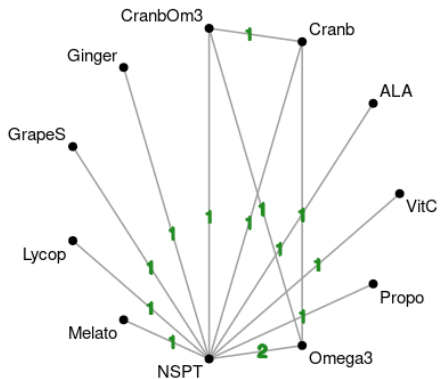
Figure 4. Network plot for included studies. Numbers in lines show number of included studies in direct comparisons (ALA: alpha lipoic acid; Cranb: cranberry; CranbOm3: cranberry plus omega- 3; GrapeS: grape seed; Lycop: lycopene; Melato: melatonin; NSPT: nonsurgical periodontal Propo: propolis; VitC: vitamin C). therapy: Propo: propolis; VitC: vitamin C). Table 2. Classification of 10 interventions for HbA1c control in patients with type 2 diabetes mellitus and periodontitis following the partially contextualized framework for NMA.